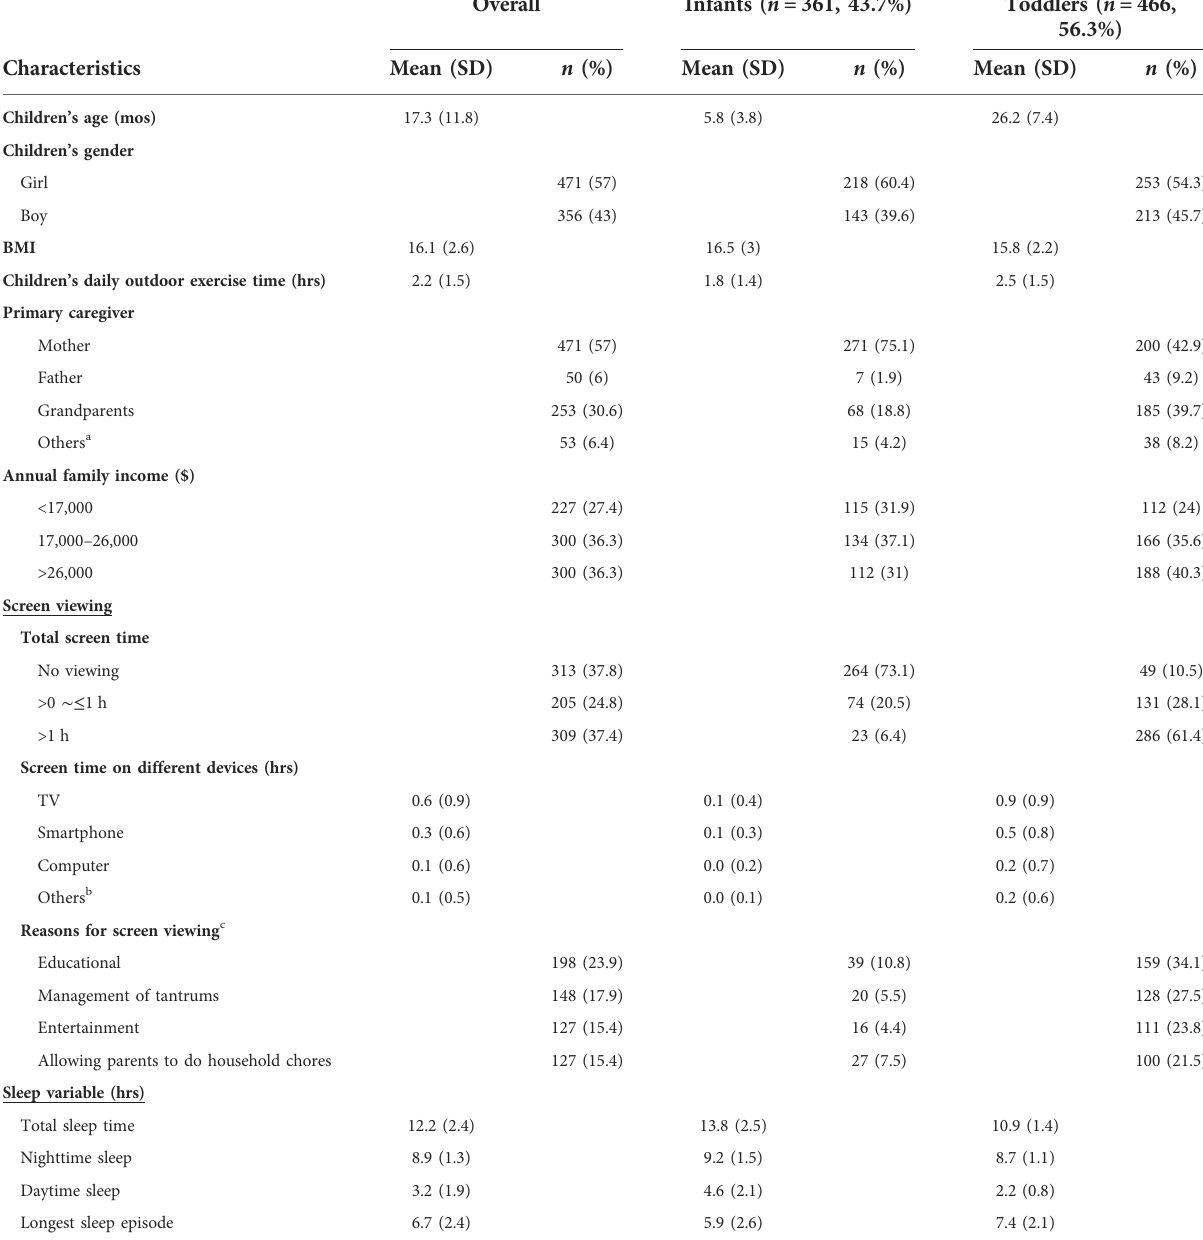
TABLE 1 Sociodemographic data of participants ( n